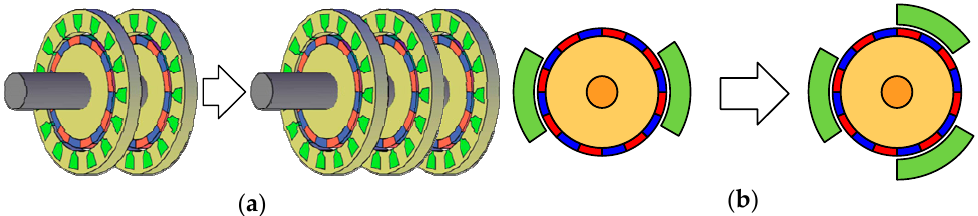
Figure 3. Single shaft multiple motor drive: ( a ) axial connection of motors, 2 motors vs. 3 motors; ( b ) sectional motor, 2 segments vs. 3 segments.